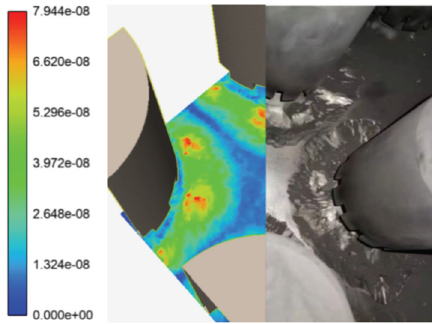
Fig. 11. Failure veri fi cation diagram. Table 4. Result of orthogonal test